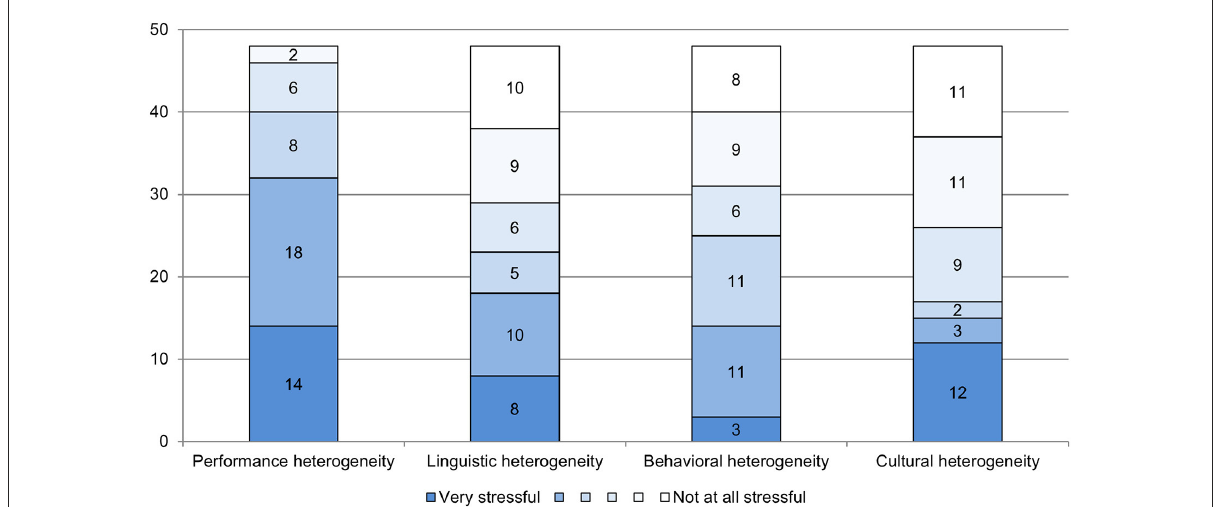
FIGURE3 Perception of stress with regard to various aspects of class heterogeneity (absolute frequencies; scale from 1 = not at all stressful to 6 = very stressful; source: survey of teachers in preparation classes, n = 48).